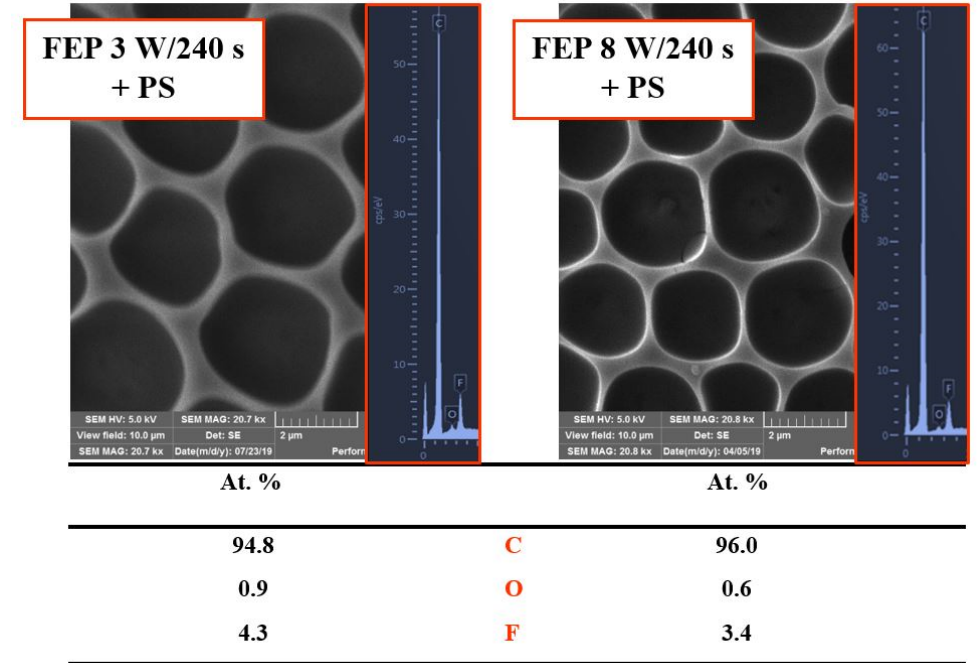
Figure 3. Scanning electron microscopy images (10 × 10 µ m 2 ) of plasma-modified fluorinated ethylene propylene (FEP) treated at different plasma discharges (3 and 8 W), with a polystyrene (PS) layer forming a honeycomb-like pattern. On the right side, corresponding energy-dispersive X-ray spectroscopy graphs and a table of element concentrations on the surface are depicted [27].